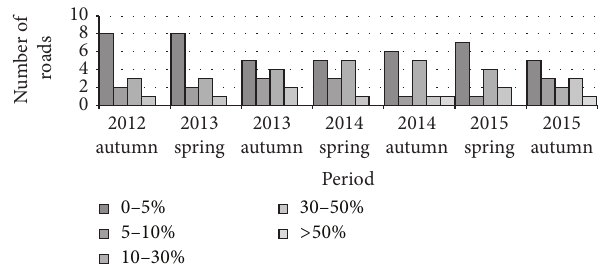
Figure 13: The number of roads sections covered with double Otta Seal according to severity of failure P 1